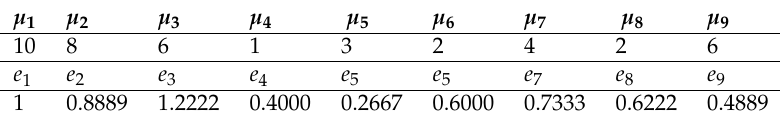
Table 1. The service rates and the relative arrival rates.